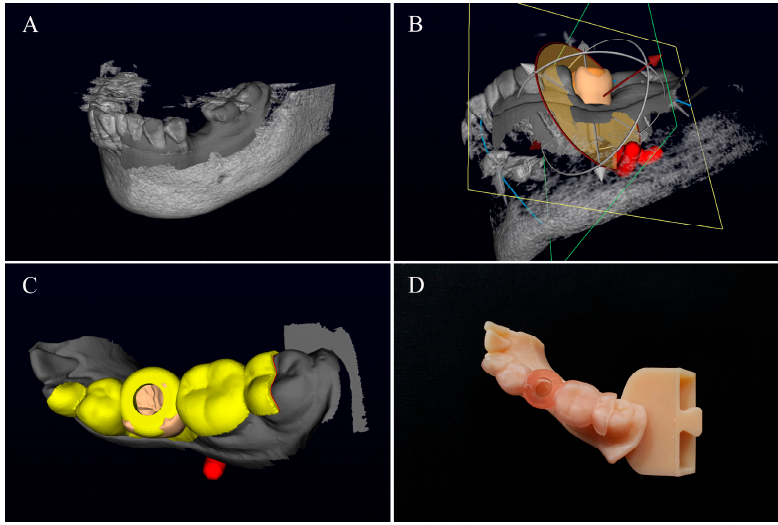
Figure 1. Process of surgical guide production. ( A ) Overlap between data. ( B ) Implant position plan. ( C ) Virtual surgical guide production. ( D ) Surgical guide production through a 3D printer.